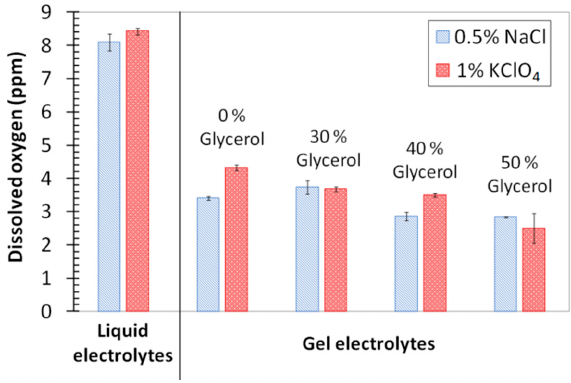
Figure 2. Amount of oxygen dissolved in the various electrolytes under study.